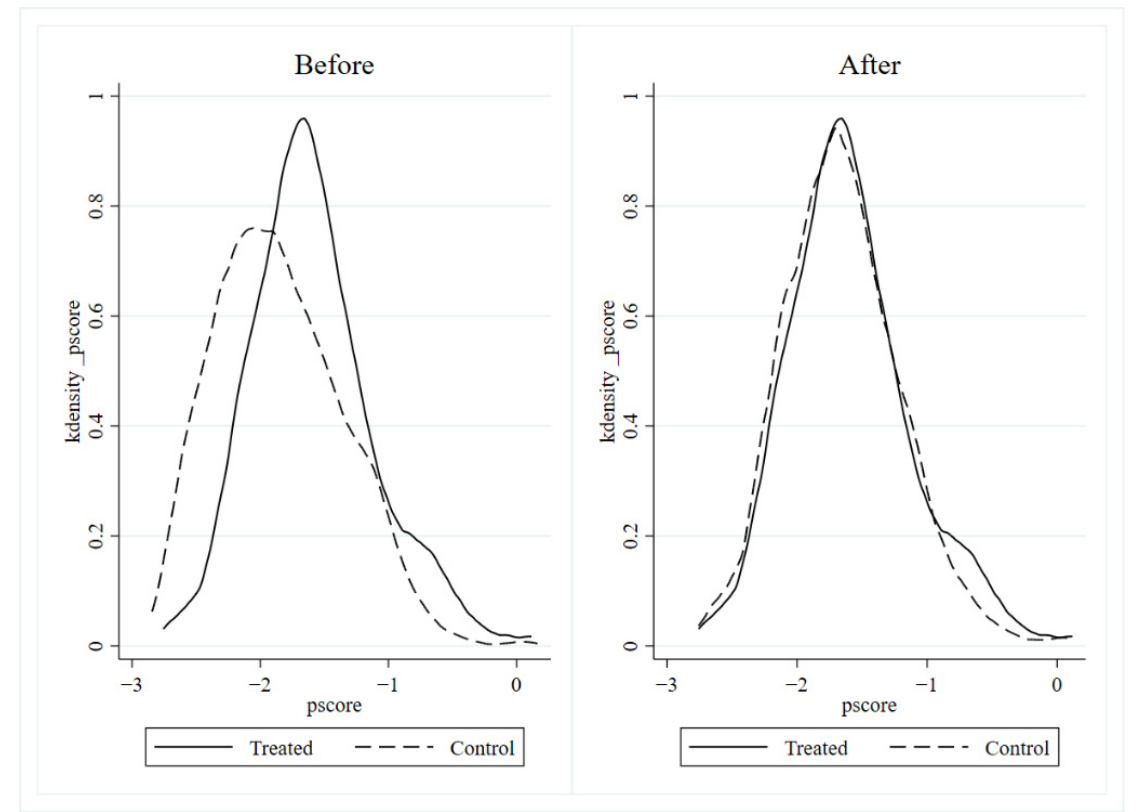
Figure 2. Kernel density function before and after PSM in treatment group and control group.